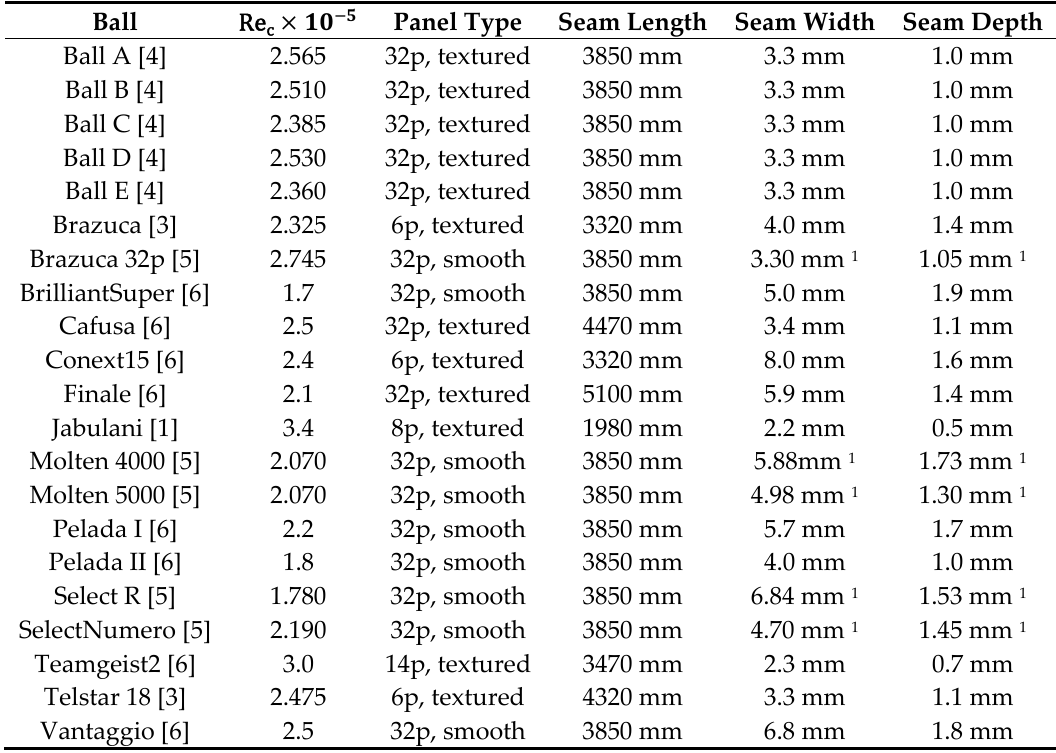
Table 1. Balls tested during several studies [1–6], each with their critical Reynolds number (Re c ), panel type (p is number of panels), total seam length, seam width, and seam